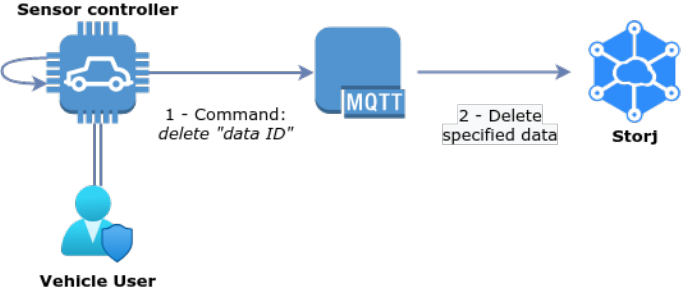
Figure 7. Data erasure request.